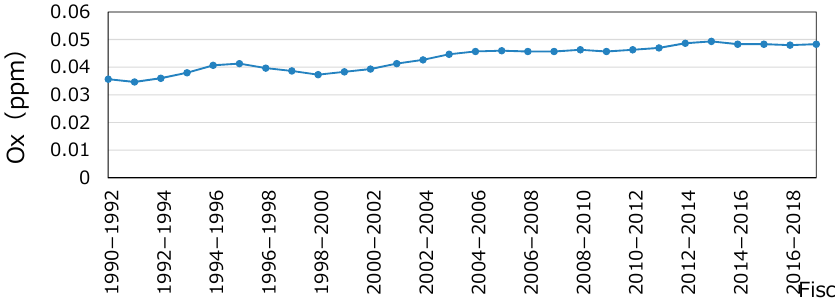
Figure 7. Trend in the three-year moving average for daily maximum of Ox concentrations. Ox: daily maximum of hourly Ox at all nine General sta.